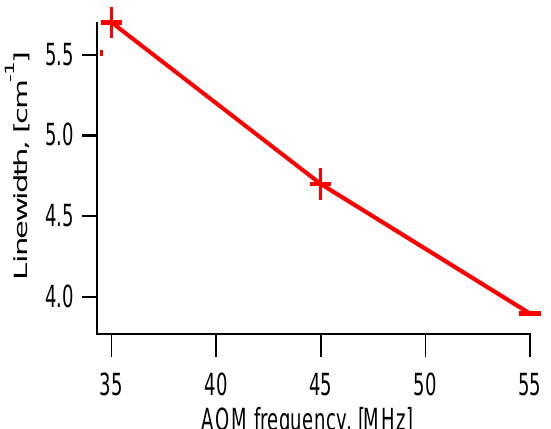
Figure 8. Linewidth dependence on AOM frequency.